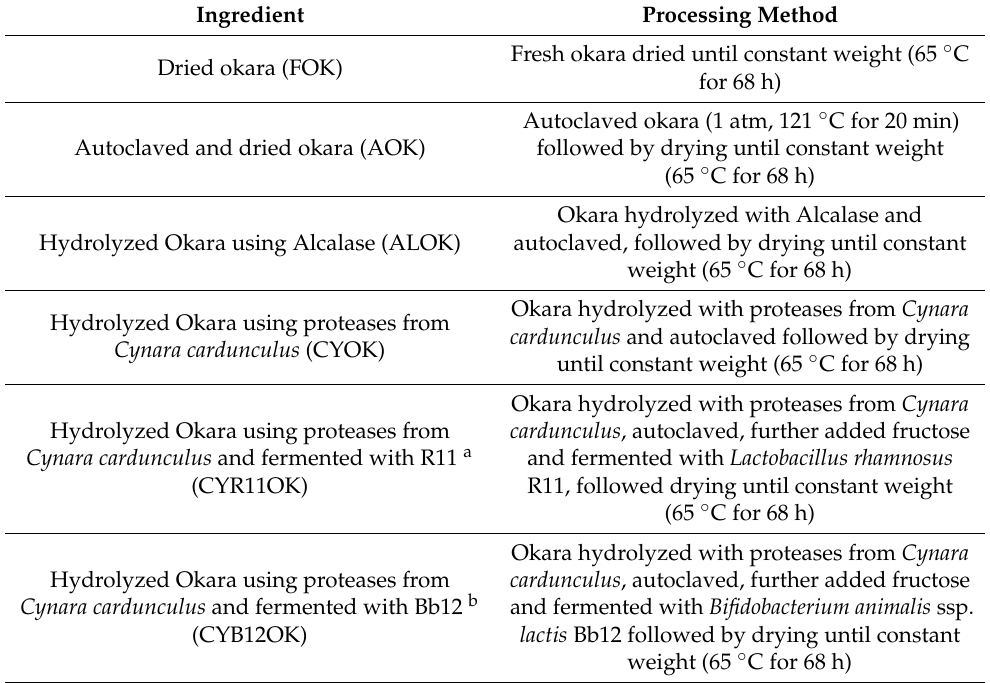
Table 1. Process applied in by-product from soy beverage to obtain okara meal used as test ingredients. Ingredient Processing Method Fresh okara dried until constant weight (65 ◦ C Dried okara (FOK) for 68 h) Autoclaved okara (1 atm, 121 ◦ C for 20 min) Autoclaved and dried okara (AOK) followed by drying until constant weight (65 ◦ C for 68